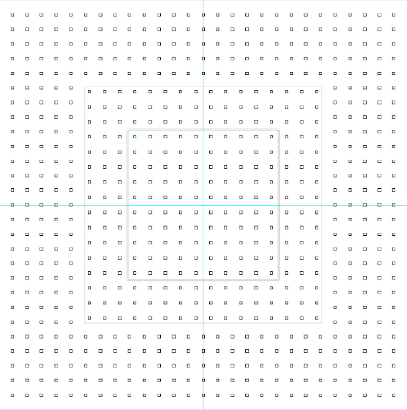
Figure 3. Analysis point grid diagram.